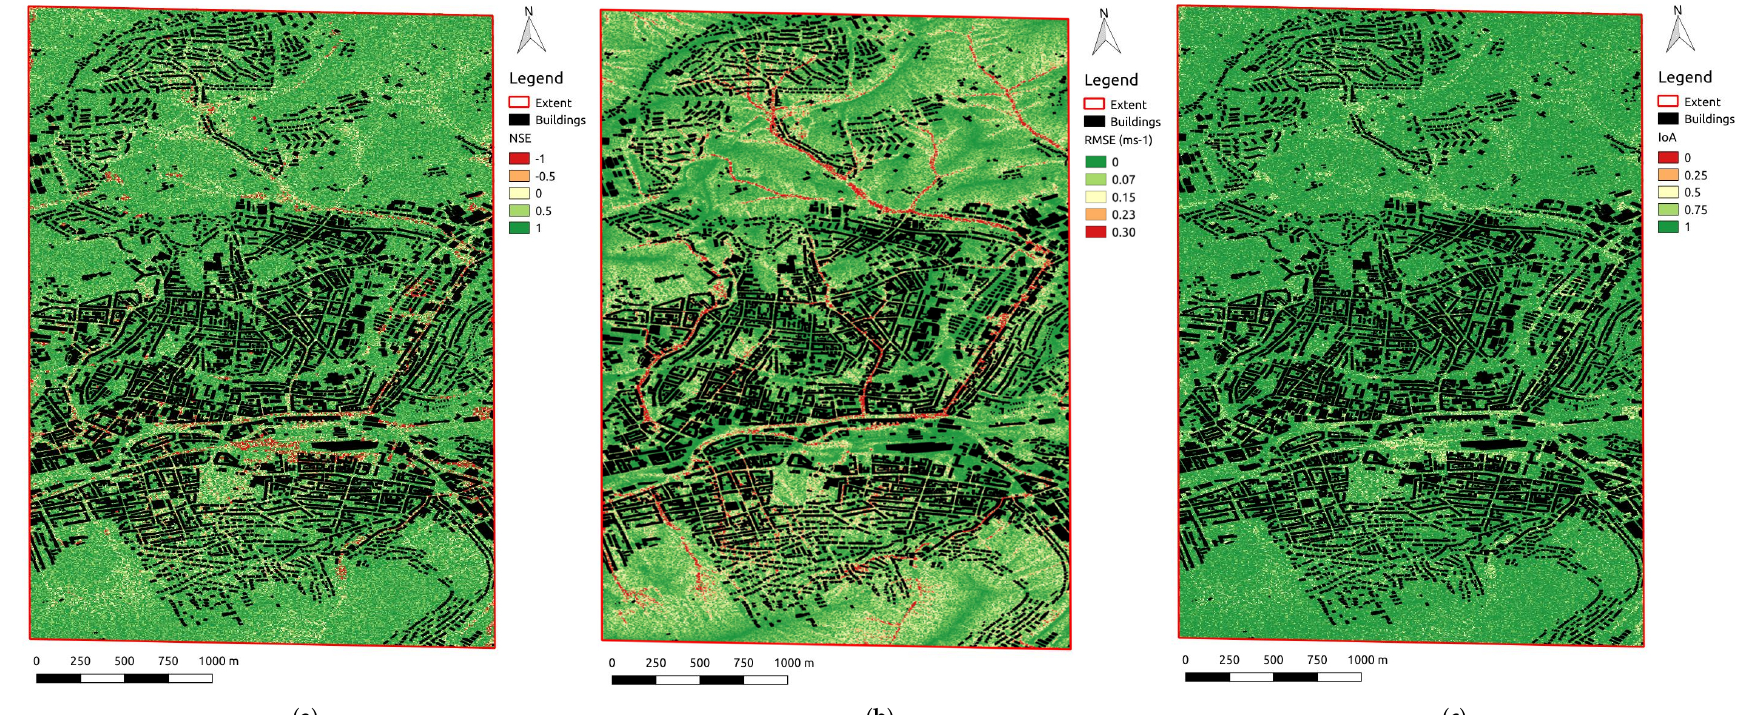
Figure 8. Spatial distribution of model performance for velocity. Green indicates very good or perfect agreement. ( a ) NSE; ( b ) RMSE; ( c )